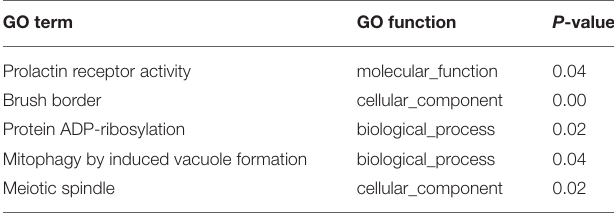
TABLE 1 | Differentially expressed lncRNA-gene pairs between high and low egg production groups.